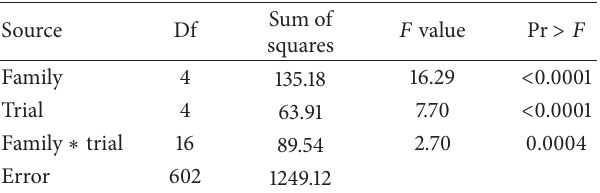
Table 3: ANOVA table for effect of family and trial on chip color. Source